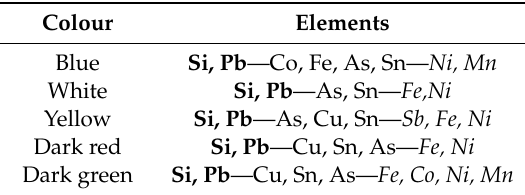
Table 6. The enamels analysed by pXRF ( Major —minor— traces